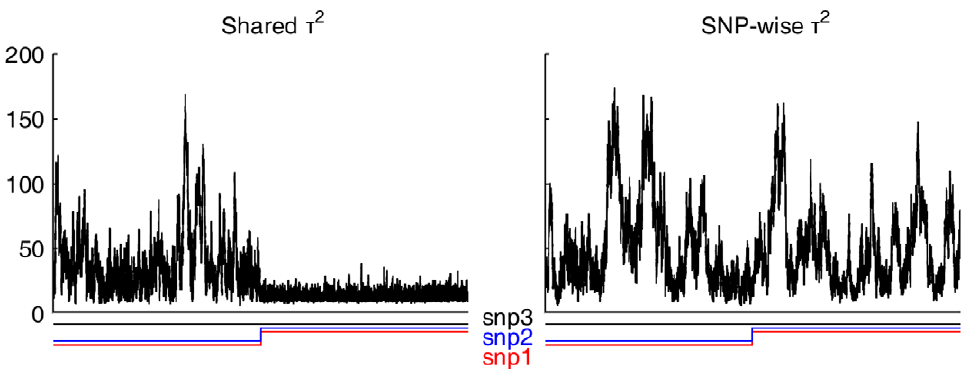
Figure 5. Demonstration of multimodality with shared t 2 parameter in the LDL-C data. The multimodality is related to the SNP pair, whose state change is shown (snp1 and snp2; c snp3 ~ 1 for the whole period) together with the corresponding parts of the trace of model size samples for two MCMC chains with the different priors.